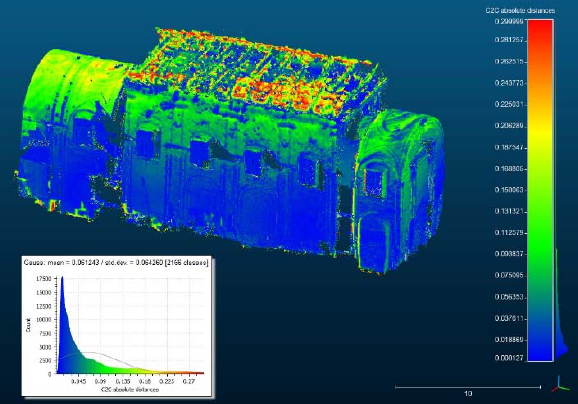
Figure 9: Results of the comparisons of point clouds in Cloud Compare: Faro Focus 3D s120 and Nikon Coolpix